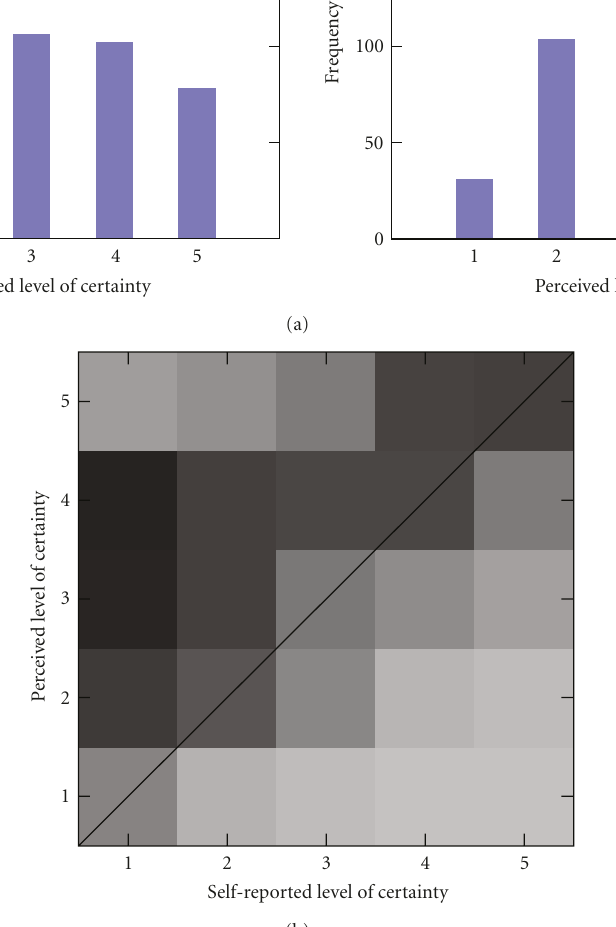
Figure 1: (a) Histograms illustrating the distribution of self-reported certainty and (quantized) perceived certainty in our corpus; (b) heat map illustrating the relative frequencies of utterances grouped according to both self-reported certainty and (quantized) perceived certainty (darker means more